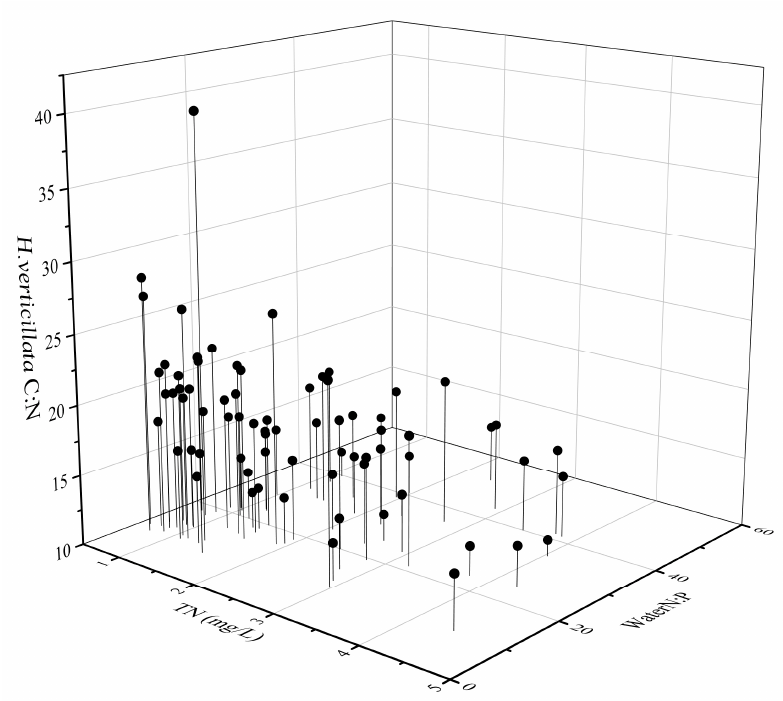
Figure 2. The relationship between H. verticillata C:N, water TN, and water N:P.